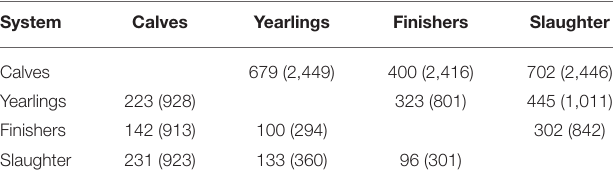
TABLE 1 | Contingency table of the number of beef (lower diagonal) and dairy (upper diagonal) AI sires with progeny in each pairwise system comparison as a function, in parentheses, of the total number of AI sires used across both